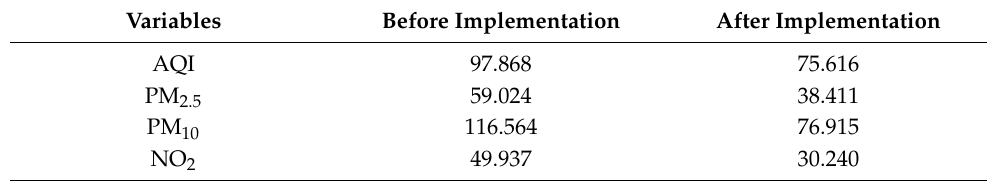
Table 2. Changes in policy